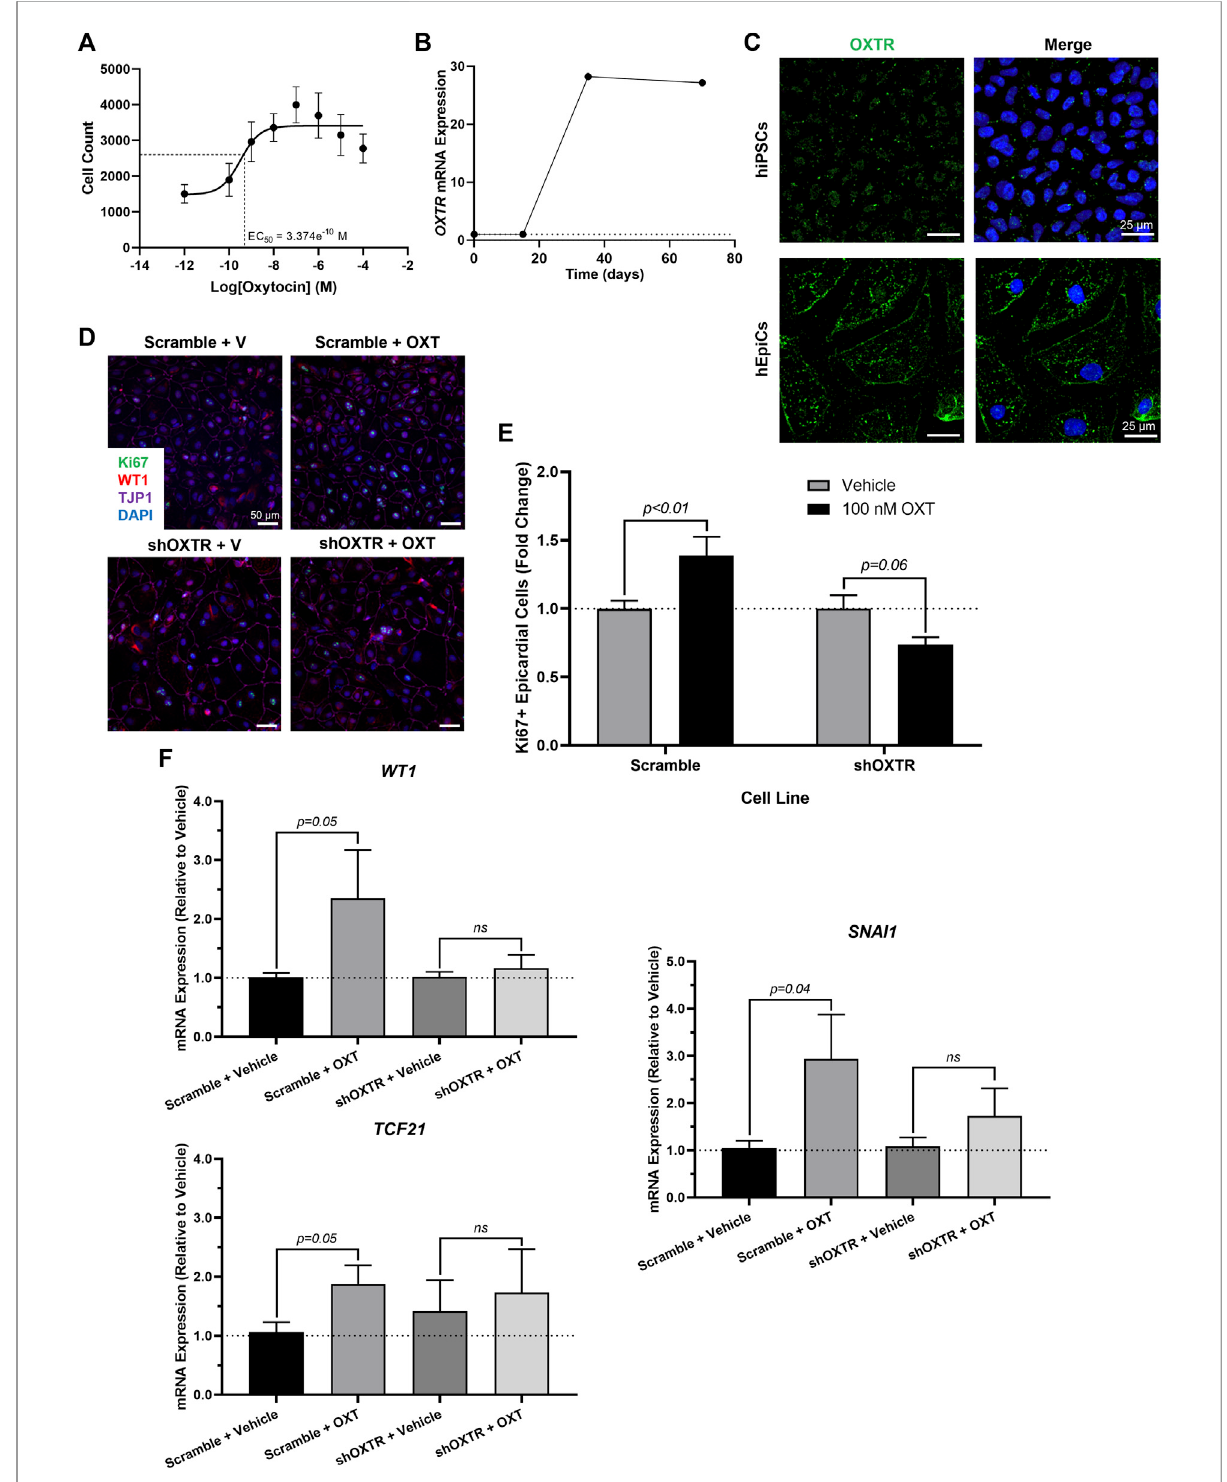
FIGURE 3 OXTR Knockdown Decreases Proliferation and Activation of hiPSC-Derived Epicardial Cells. (A) Dose-response data for hEpiCs exposed to different concentrations of OXT over the course of 3 days, expressed as number of nuclei at each concentration; n = 10 per concentration. (B) Time course qRT-PCR data for OXTR in hEpiCs, dashed line corresponds to expression in undifferentiated hiPSCs. (C) Confocal immuno fl uorescent images for OXTR (green) and DAPI (blue) showing oxytocin receptor expression on the cell membrane and in the peri-nuclear region only in